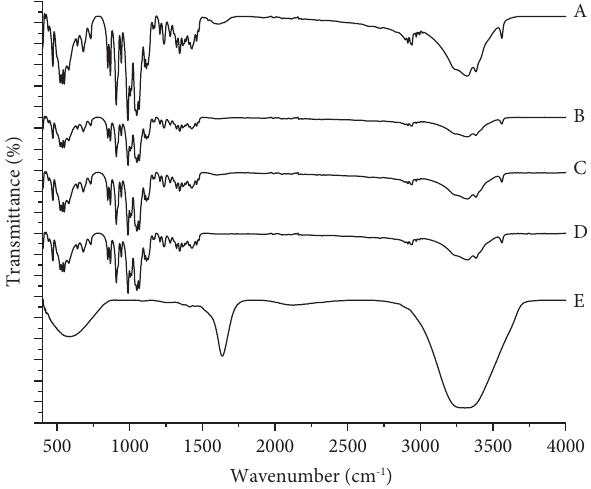
Figure 3: FTIR-ATR spectra of cocrystallized powders ( A ), vacuum-dried powders ( B ), plated powders ( C ), sucrose ( D ), and moringa leaves extract ( E